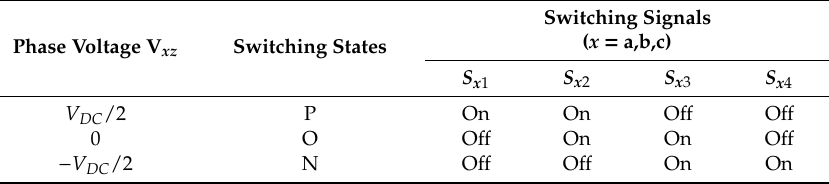
Table 1. Relationship between phase voltage and switching signals.